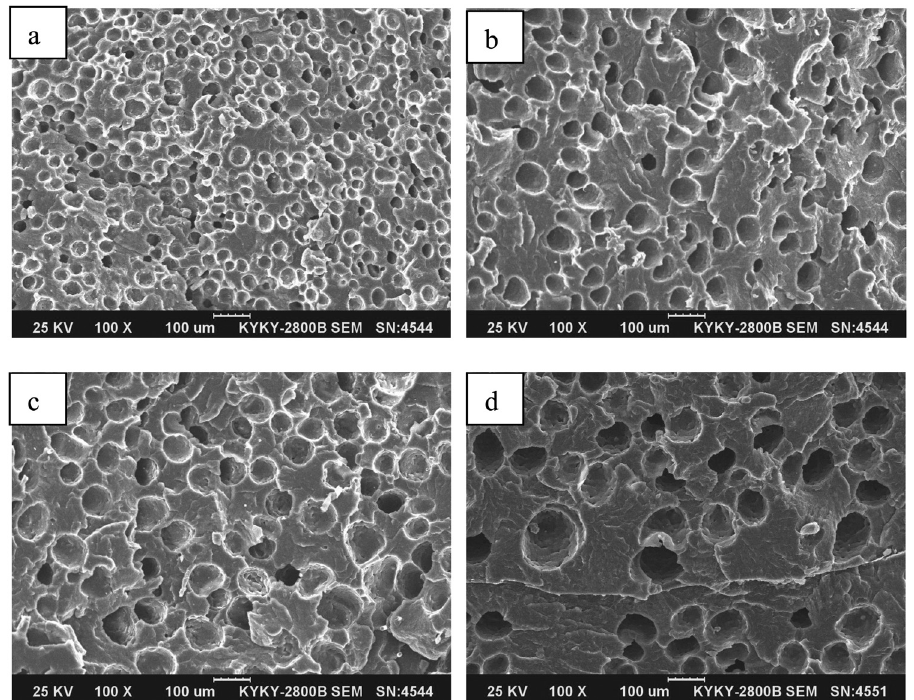
Figure 3: Freeze - fracture SEM images of the PP foams with various cell sizes. Scale bar: 100 μ m. Average cell size: ( a ) 31 μ m, ( b ) 46 μ m, ( c ) 73 μ m, and ( d ) 87 μ